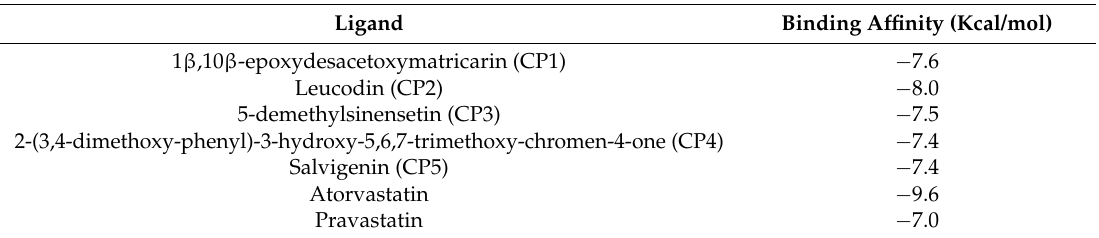
Figure 13. Bound conformer of ligands interacting with the substrate binding sites of HMGR (pravastatin). Table 4. The binding affinity of different ligands (the 5 compounds and 2 selected statins).